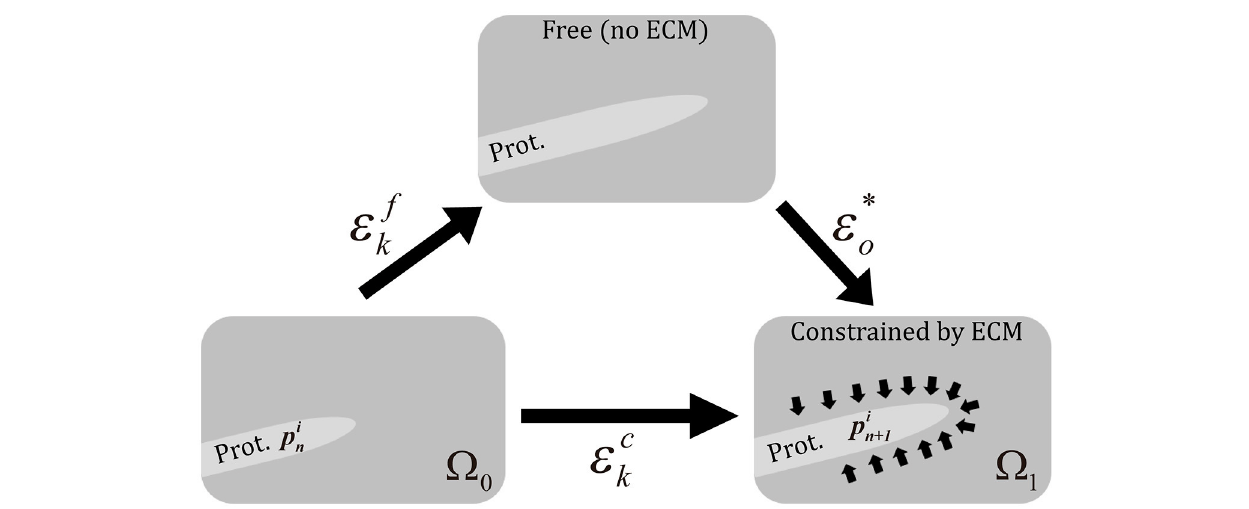
FIGURE 3 | Scheme of the three different configurations in protrusion dynamics. ε f k represents the free expansion/retraction (ECM does not restrict protrusions deformation) Cauchy’s strain tensor. ε o * is the compatibility Cauchy’s strain tensor. ε c k represents the total deformation Cauchy’s strain tensor. We assume infinitesimal deformation.